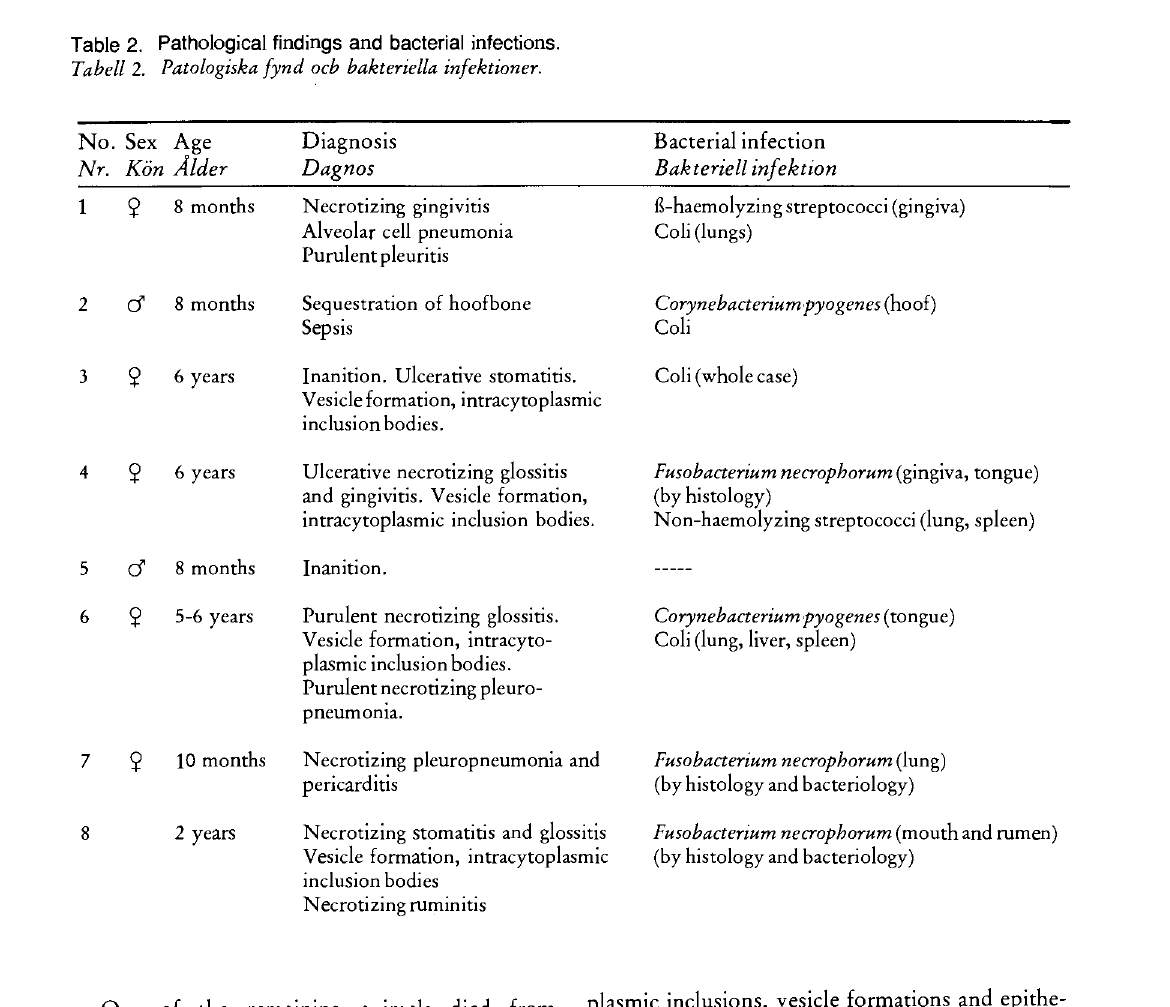
Table 2. Pathological findings and bacterial